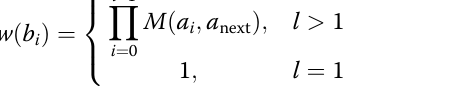
Algorithm 1 Node Social Features Relationship Evaluation Algorithm